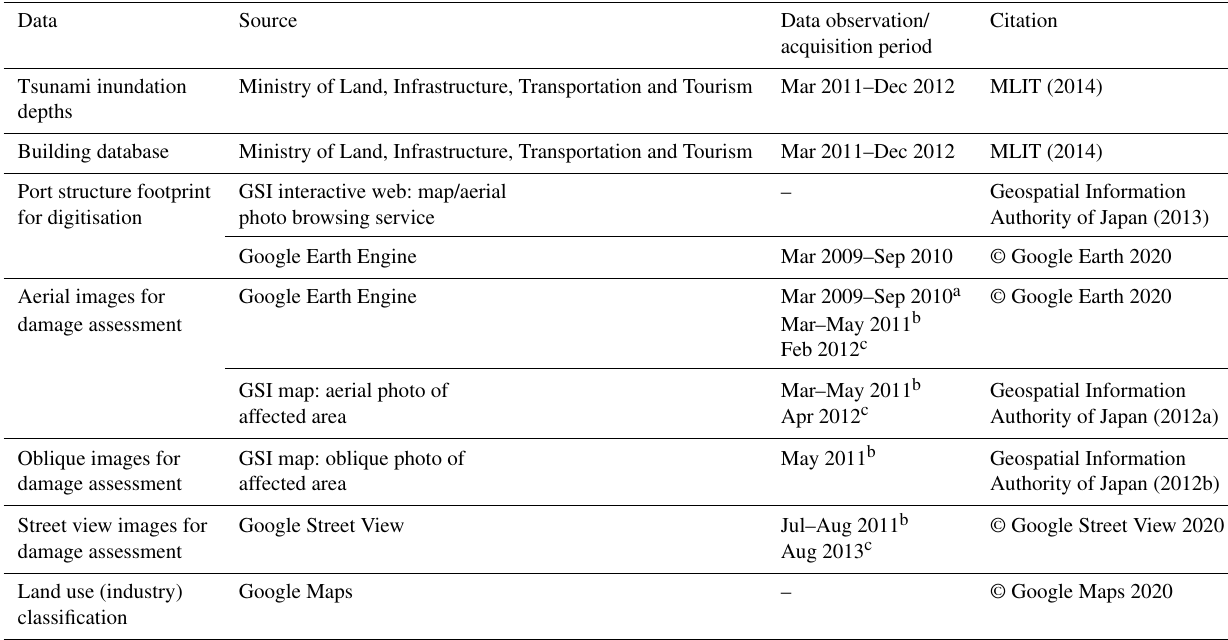
Table 1. Data used in this study, their sources and the reference period from which data are taken.